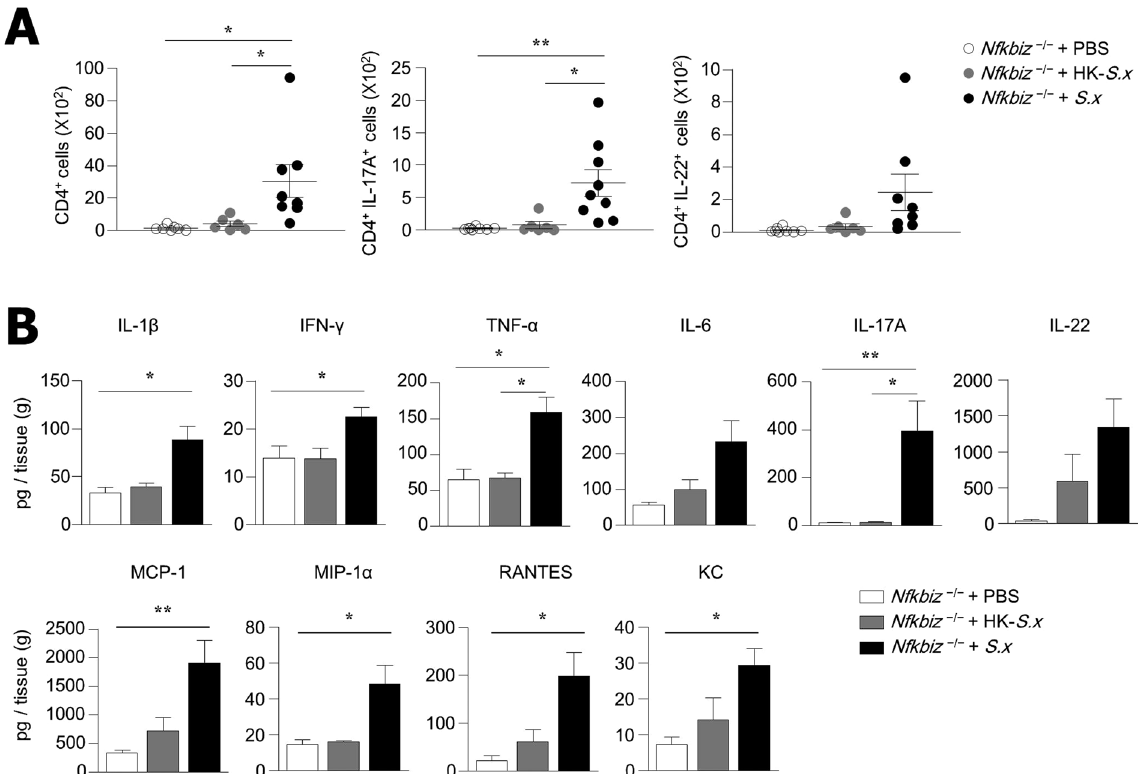
Figure 7. Topical application of S. xylosus leads to differentiation of Th17 cells in skin of Nfkbiz − / − mice. ( A ) Flow cytometry analysis of IL-17A and IL-22 production in CD4 + cells from skin of PBS, heat-killed S. xylosus (HK-S.x) , or S. xylosus(S.x) -inoculated Nfkbiz − / − mice. ( B ) Cytokine and chemokine levels in skin homogenate. Data are representative of three independent experiments. Data are mean ± s.e.m. * p < 0.05, ** p <